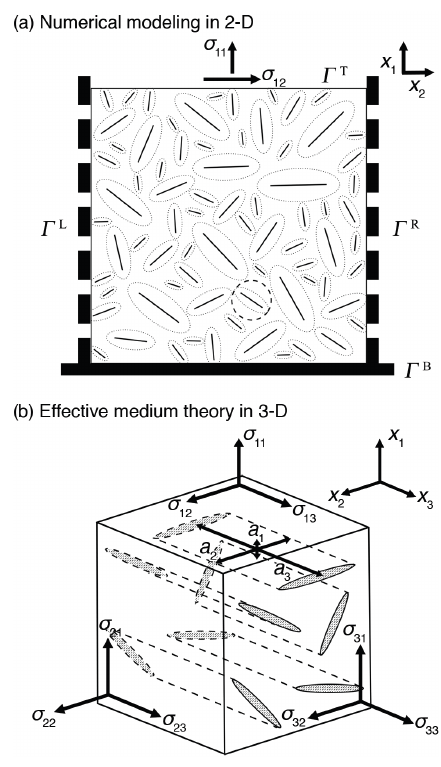
Figure 2. (a) Two-dimensional numerical modeling scheme for a rock containing randomly oriented, well-separated fractures, to which a normal or shear stress is applied at the top boundary. (b) Scheme for 3-D effective medium modeling for a rock con- taining ellipsoidal fractures, randomly oriented in the x 1 – x 2 plane. Consistent with the numerical model, the applied normal stress σ 11 and shear stress σ 12 is orthogonal to the long ellipsoid axis a 3 , whose orientation is held